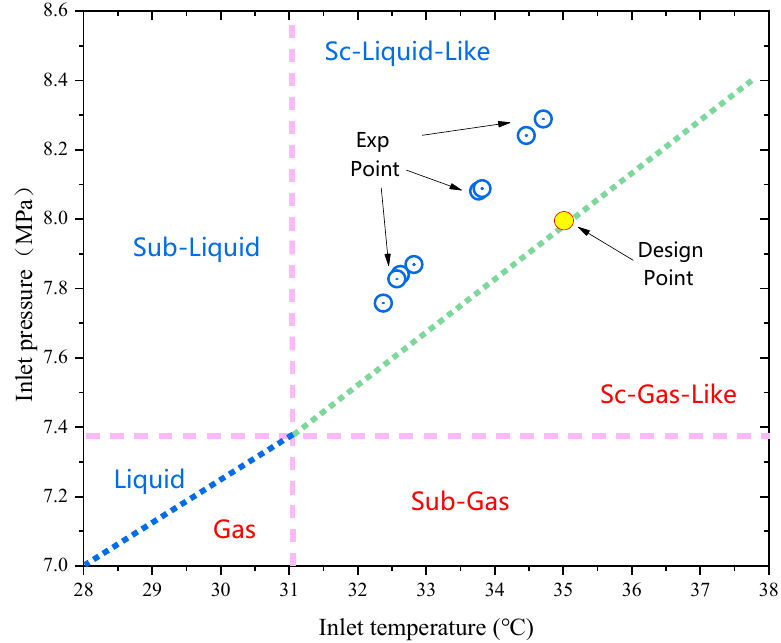
Figure 12. The compressor inlet conditions in the test (@ 31,000 ± 1000 RPM).